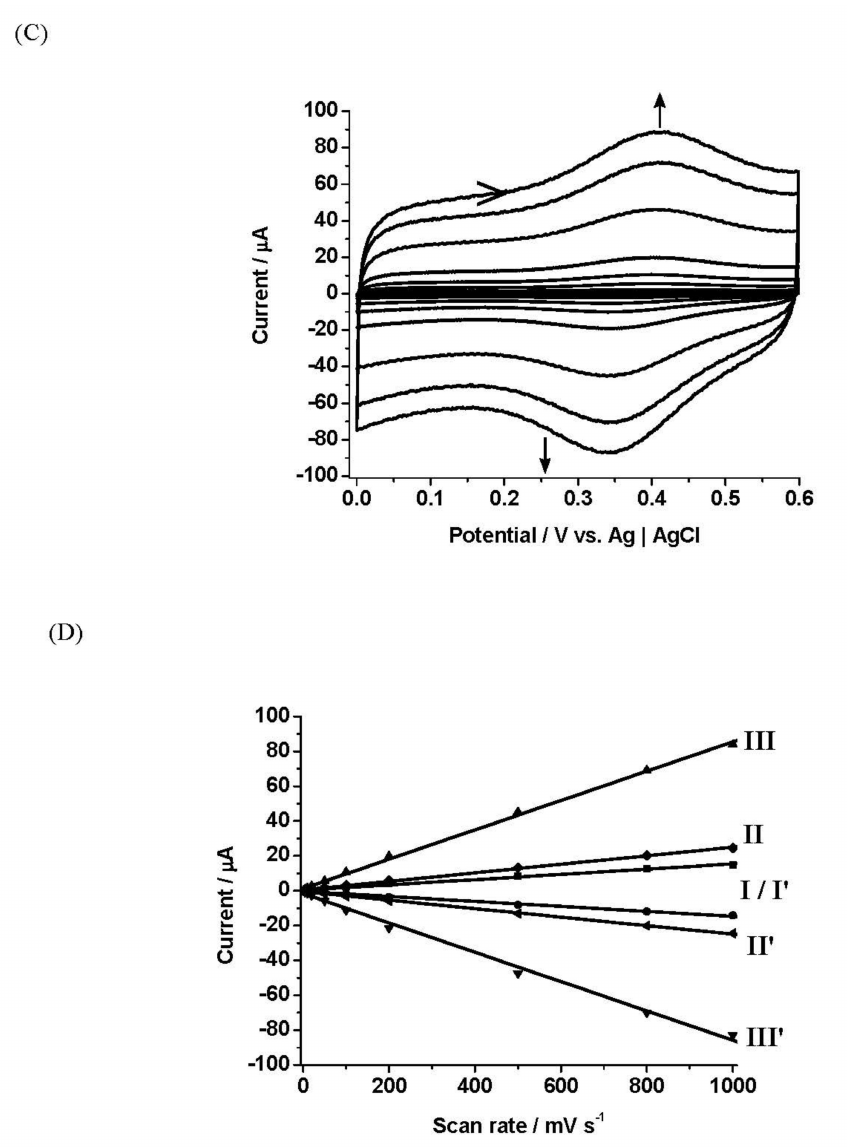
Figure 3. ( A ) Polymerisation of 3-(1 H -pyrrol-1-yl)propanamidoferrocene ( 6 ) and EDOT in ratio of 1:5 (1 mM:5 mM) at a GCE in aqueous LiClO 4 (10 mM). Potential sweep, 0–+1.20 V vs. Ag|AgCl, scan rate 100 mV s − 1 . ( B ) Stability of the films of 16-EDOT in ratio of 1:5 (1 mM:5 mM) at a GCE in supporting electrolyte. Potential sweep, 0–+0.60 V vs. Ag|AgCl, scan rate 25 mV s − 1 for 25 cycles. ( C ) Multiple scan rate study of the films of 6-EDOT in ratio of 1:5 (1 mM:5 mM) at a GCE. Potential sweep, 0–+0.60 V vs. Ag|AgCl, scan rate of 1–1000 mV s − 1 for 3 cycles; ( D ) i p ( µ A) vs. scan rate (mV s − 1 ) for the films of 6-EDOT. I and I’ = i pa and i pc in ratio of Fc:EDOT 1:1 (1 mM:1 mM); II and II’ = i pa and i pc in ratio of Fc:pyrrole 1:2.5 (1 mM:2.5 mM); III and III’ = i pa and i pc in ratio of Fc:pyrrole 1:5 (1 mM:5